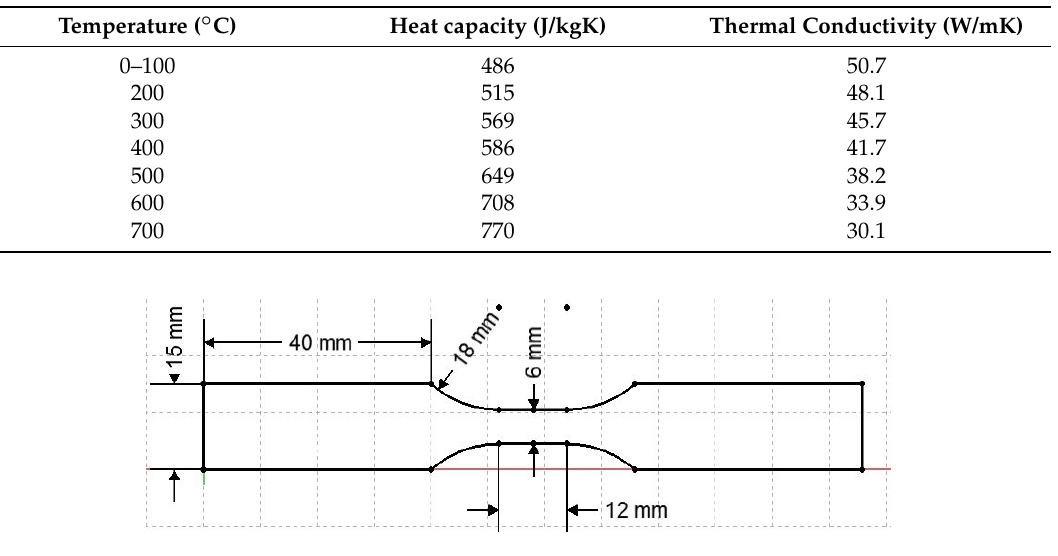
Figure 2 . High Power Diode Laser (HPDL) system. Surface laser treatments followed the experimental schedule reported in Table 3. The experimental factors investigated were laser power and scan speed (peripheral speed calculated as the product of the rotational speed and the radius of the small section). Focus and number of passes were fixed respectively at 0 and 1. For each condition investigated (that is, 25), the rotation speed and the beam feed were properly chosen to ensure no overlap of the laser treatment. All the tests were replicated three times (75 experimental tests). After that, the area treated was characterized in terms of variations in the extent of the hardened area (i.e., (Heat Affected Zone) HAZ). Table 3. Experimental factors Factors